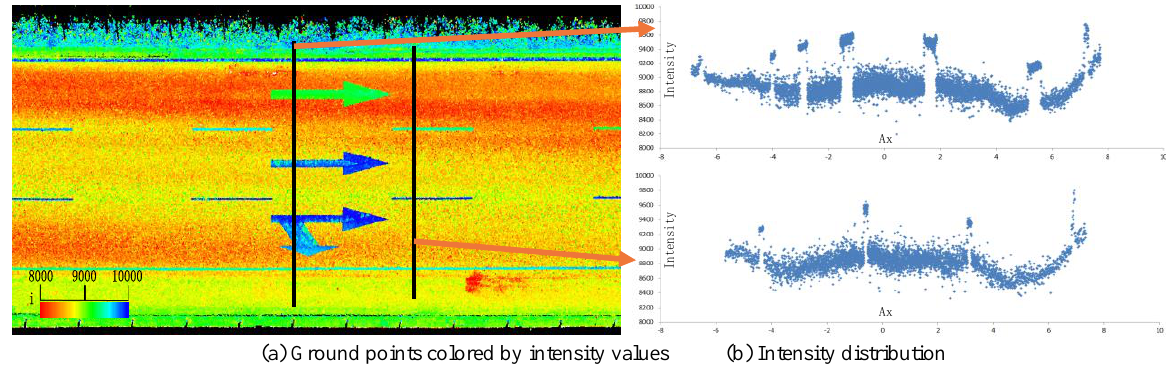
Figure 4. Intensity information of ground points